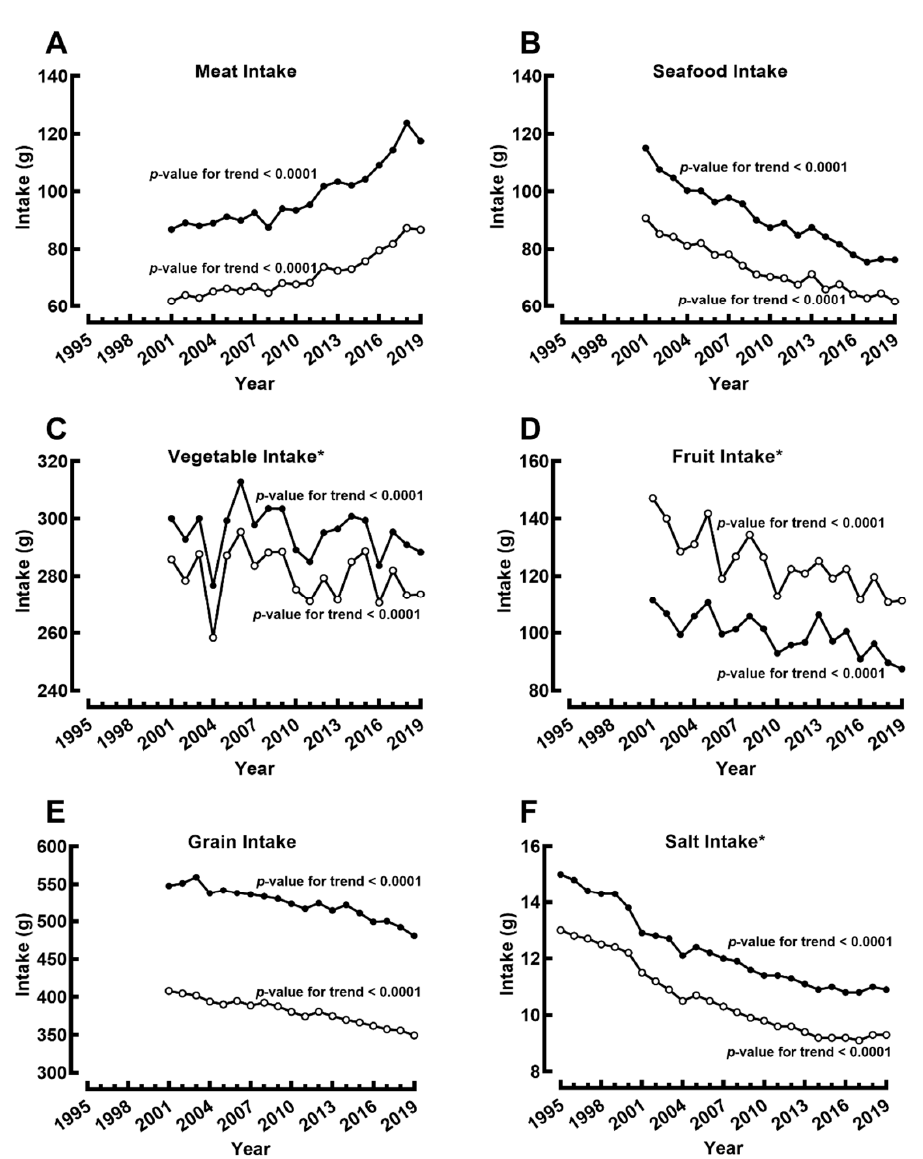
Figure 4. Changes in food group and salt intakes from 1995 to 2019 among males ( ● ) and females ( ○ ). ( A ) Total meat intake, ( B ) total seafood intake, ( C ) total vegetable intake, ( D ) total fruit intake, ( E ) total grain intake, and ( F ) total salt intake. * The 2022 targets of these parameters are set under Health Japan 21 as follows: Mean 350 g/day intake of vegetables, 70% of individuals consuming more than 100 g/day of fruit, and decrease the mean salt intake to 8 g/day.